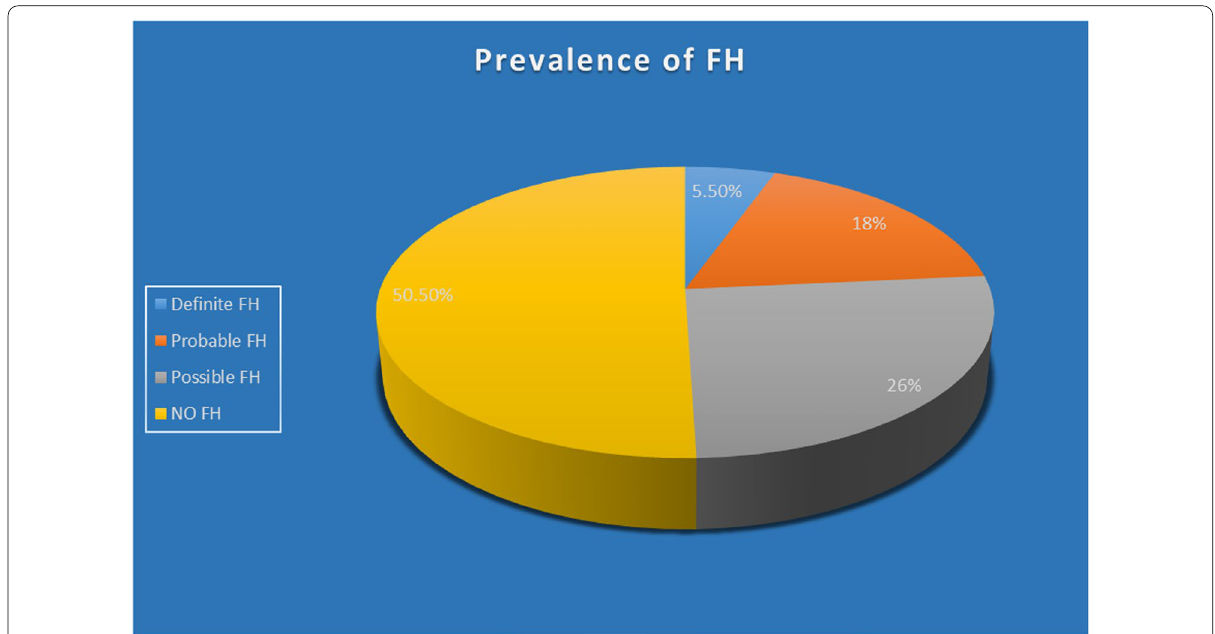
Fig. 1 Pie diagram shows the relative percentage of occurrence of different types of familial hypercholesterolemia as classified using the most effective DLCN (Dutch Lipid Clinic Network) criteria because genetic testing was not done by DNA sequencing of candidate genes (LDLR, APOB, PCSK9) in this study